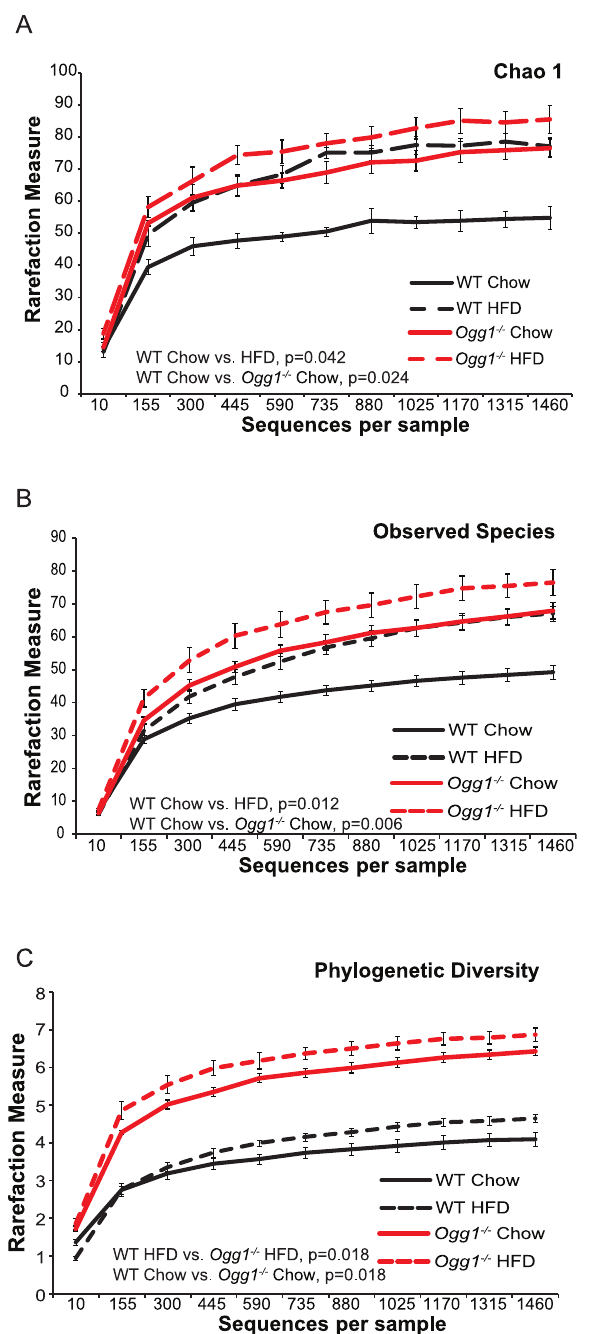
Fig 3. Alpha diversity measures of gut microbiota from chow- and HFD-fed WT and Ogg1 -/- mice. Alpha diversity measures are shown for WT and Ogg1 -/- animals. Results are from the analysis of microbial sequences recovered from the fecal samples as described in Methods. Significant differences were observed using Bonferroni-corrected p values as indicated in the figures.